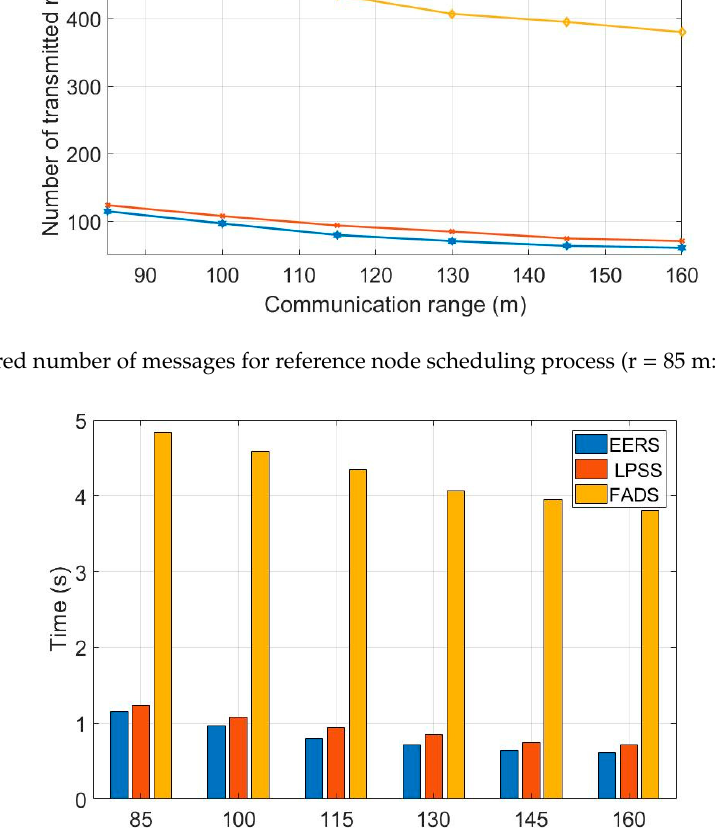
Figure 5. Required time for reference node scheduling process (r = 85 m: 160 m, N = 240).